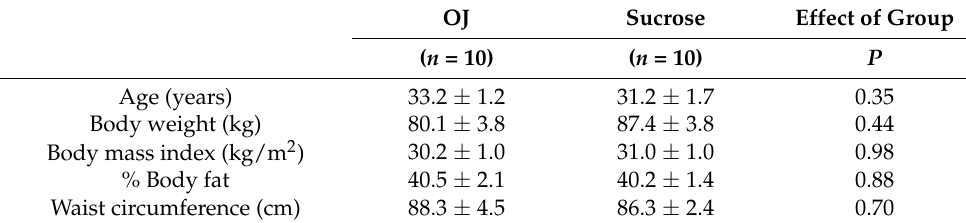
Table 1. Baseline Participant Characteristics.